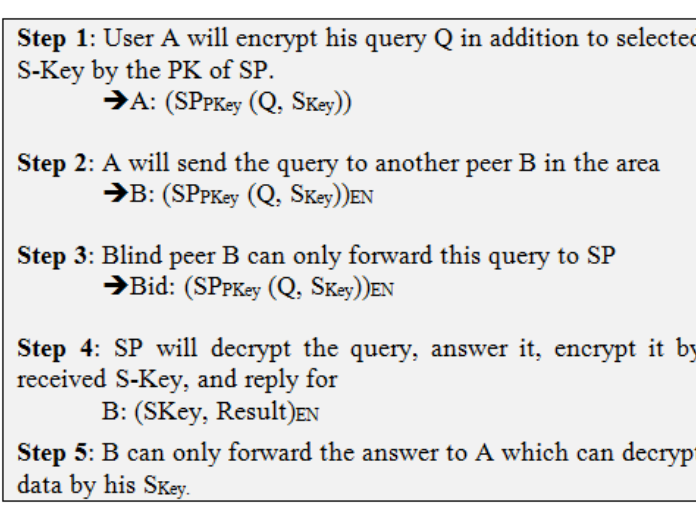
Figure 11. Blind Peer ( B L P )